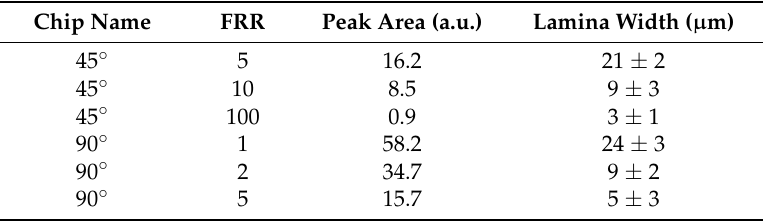
Table 1. Comparison between peaks areas of the simulations shown in Figure 2b,d and experimental lamina widths shown in the insets of Figure 1 and in Figure